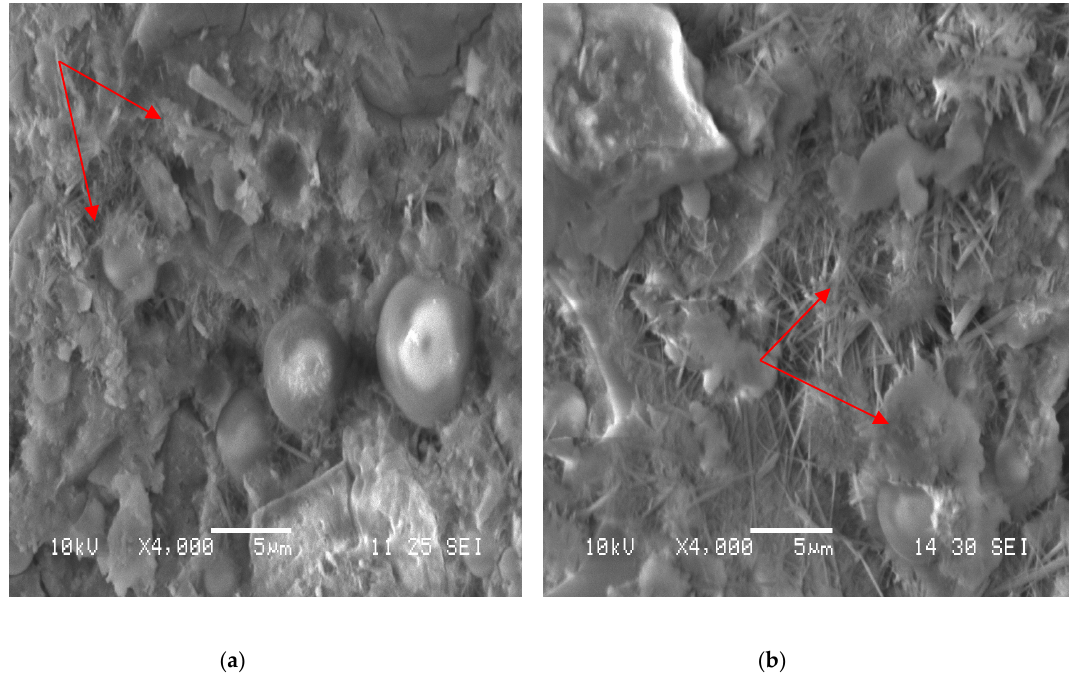
Figure 10. Microtopographyof cement paste at 7 days. ( a ) Neat cement paste. ( b ) Cement paste withGM-1 at 0.5% of the mass of cement.